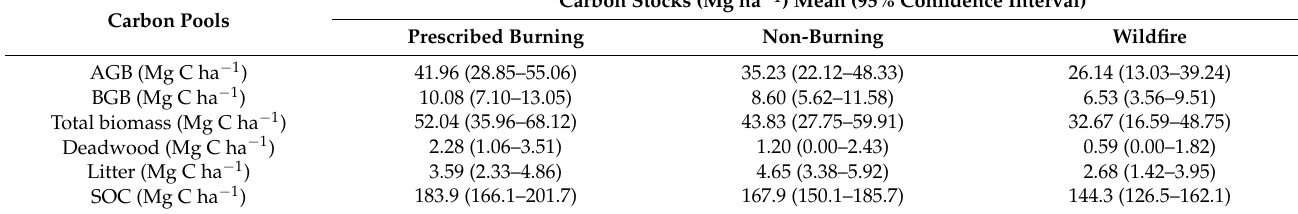
Table 3. Carbon stocks in tree biomass, forest litter, deadwood materials, and SOC between prescribed burning, non-burning, and wildfire sites of tropical highland forests in Chiapas, Mexico. AGB = aboveground biomass, BGB = belowground (root) biomass.